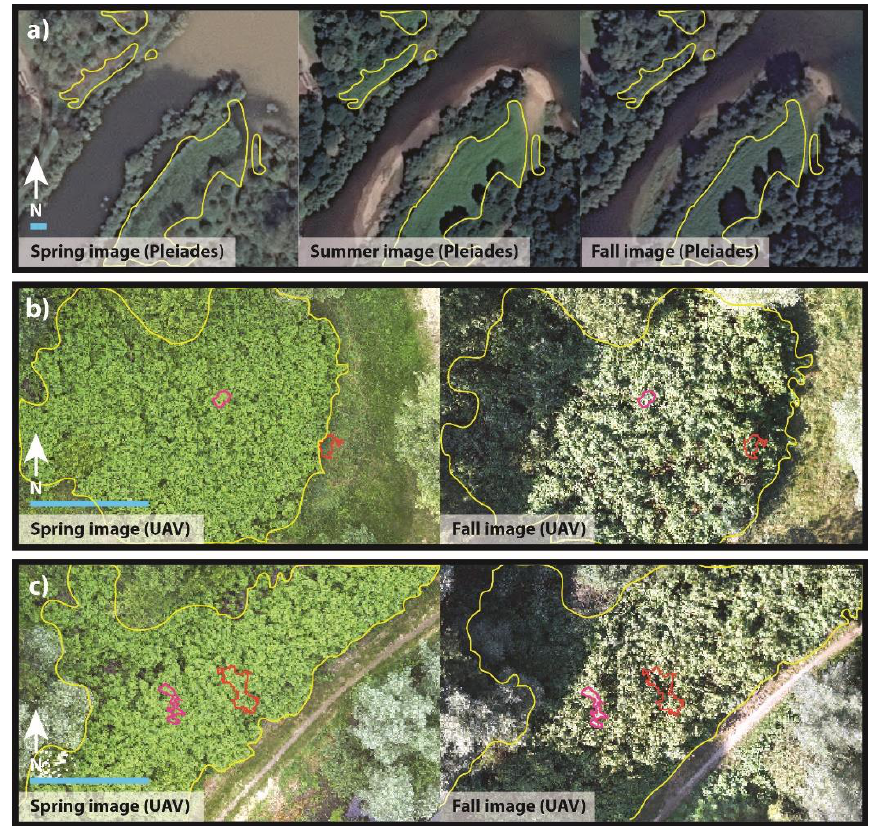
Figure 3. Illustration of some sources of errors due to the use of multi-date imagery, linked to ( a ) changing landcover, ( b ) positional misregistration and ( c ) mixed-objects. The blue scale-bar represents a length of 8 m. The red and pink lines delineate image-objects generated by the multiresolution segmentation process. The yellow lines delineate the outlines of the knotweed populations for each